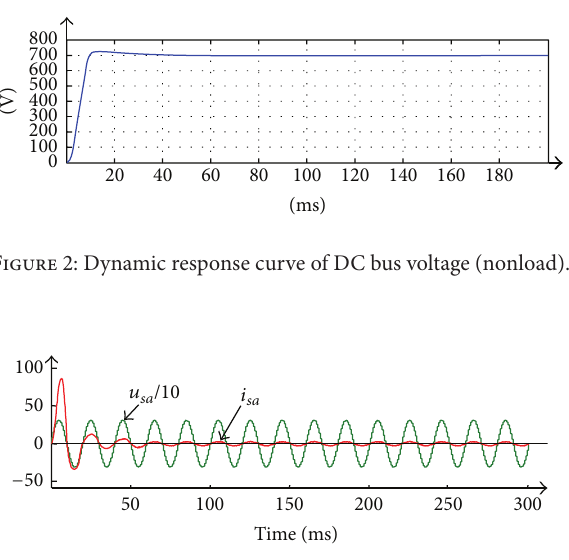
Figure 3: Waves of power grid voltage and